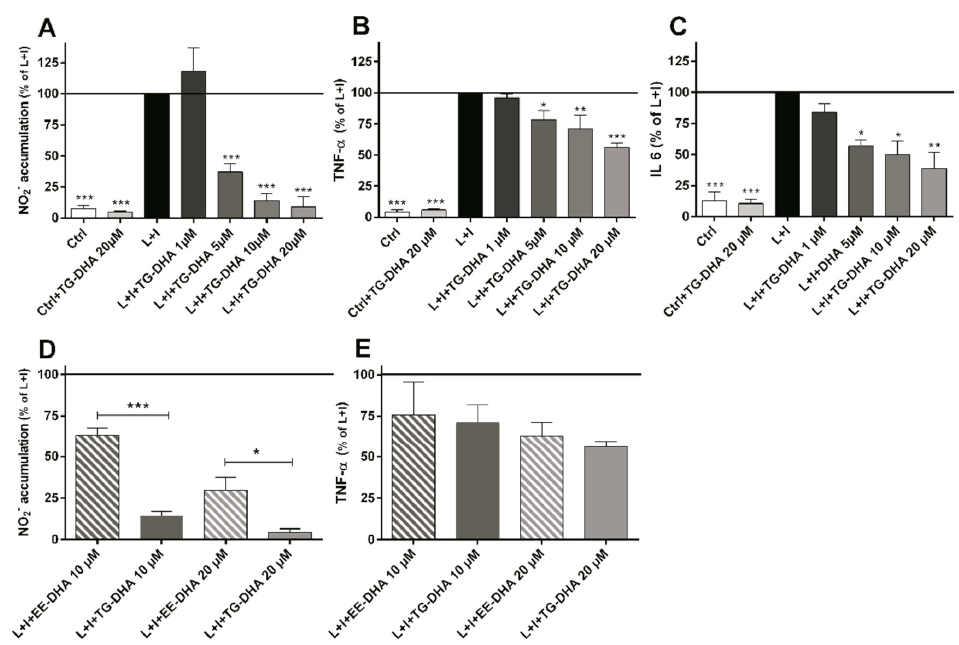
Figure 2. Treatment with DHA protected LPS + IFN- γ L + I-activated BV-2 microglia cells. Cells were treated with TG-DHA before stimulation with L+I. Culture supernatants of BV-2 cells were collected 24 h after L + I stimulation and assayed for nitrites by the Griess reaction ( A ) or TNF- α ( B ) or IL-6 ( C ) by Enzyme-Linked Immuno Sorbent Assay (ELISA). The effect of TG-DHA on BV-2 cells was compared with EE-DHA (10–20 µM) and assayed for nitrites ( D ) or TNF- α ( E ) under the same conditions described above. All experiments were performed in triplicate and repeated at least three times. Control wells contained the same final concentration of vehicle as compound-containing wells. * = p < 0.05; ** = p <0.01; *** = p < 0.005.